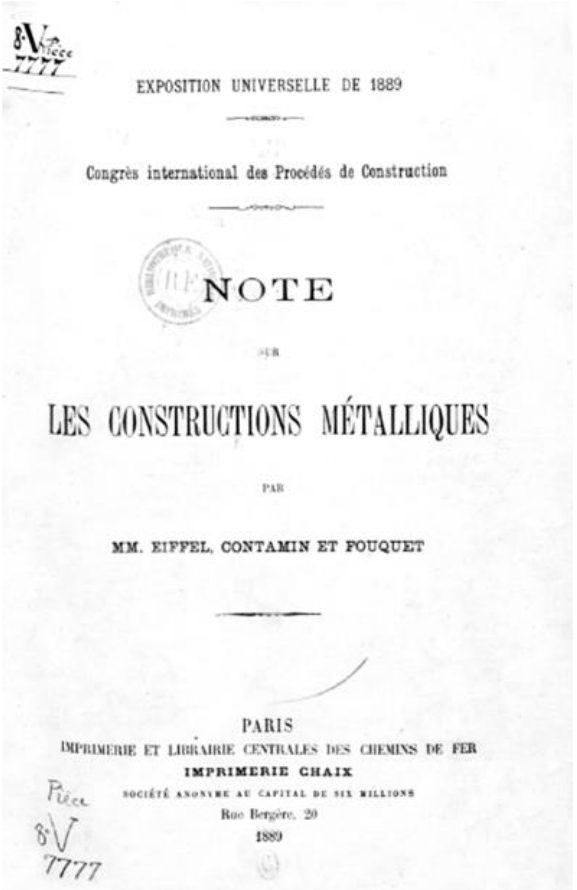
Figure 26. Minutes of the First International Congress of Construction Procedures chaired by Eiffel in Paris 1889. Source: French National Library. Piece